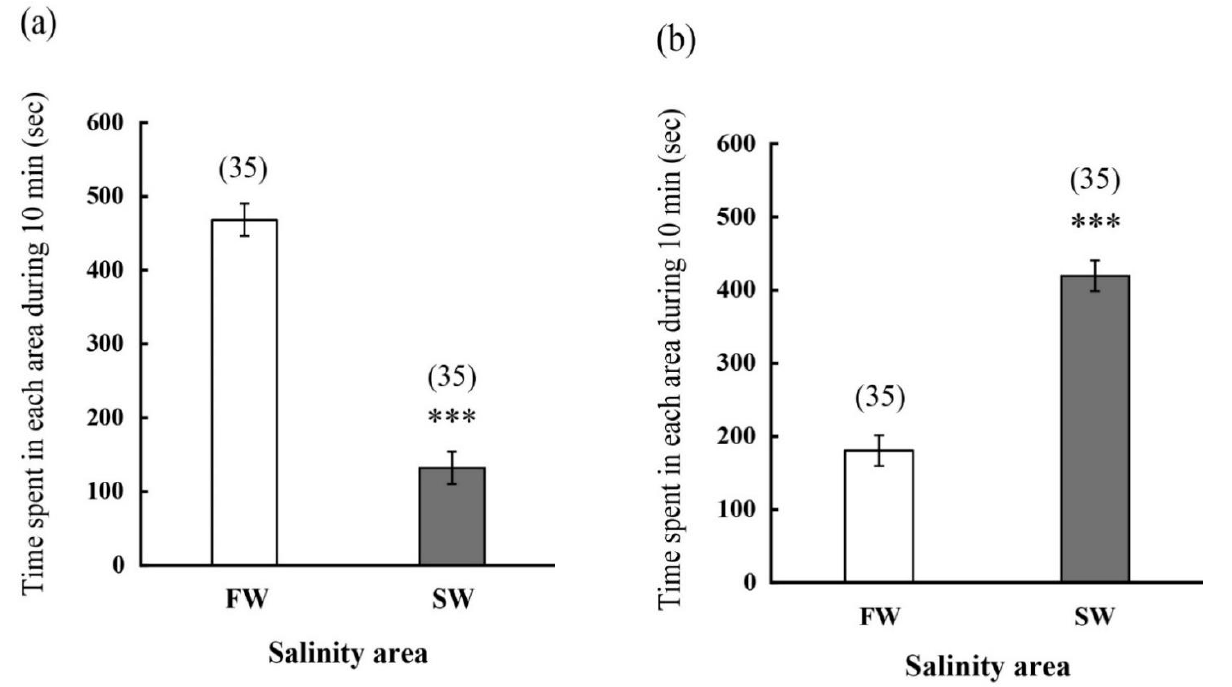
Figure 2. Time in each salinity area (FW or SW) during 10 min in FW-acclimated medakas ( a ) and SW-acclimated medakas ( b ). Numerals in parentheses indicate the number of fish examined. Data are expressed as means ± SEM. Asterisks indicate significant differences between the two groups (Wilcoxon signed-rank test, *** p < 0.001).